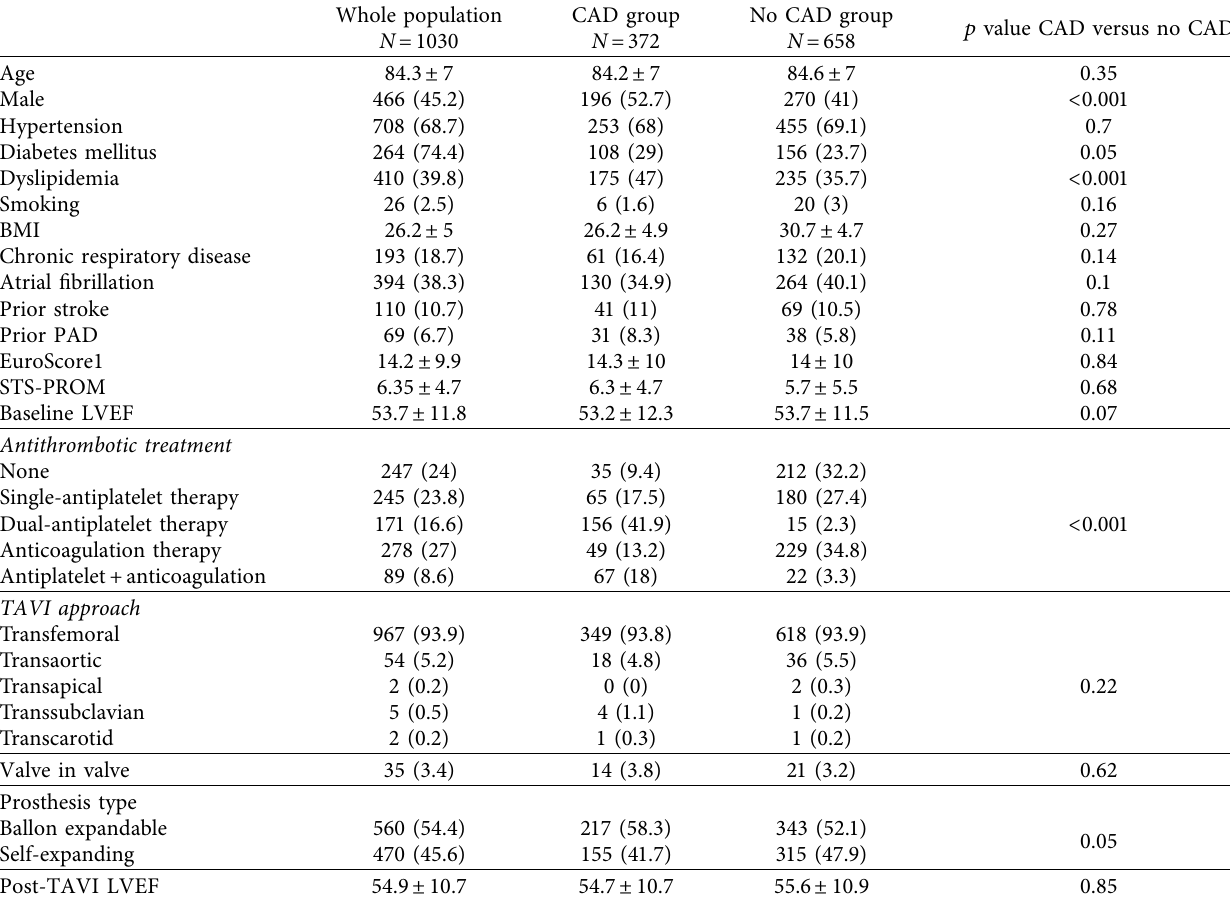
Table 1: Baseline